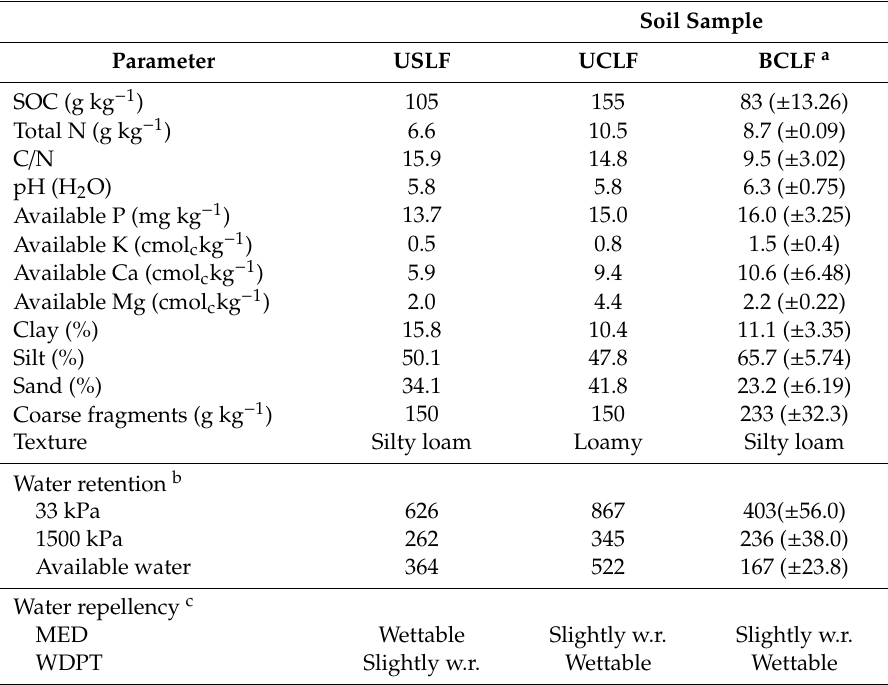
Table 1. Physicochemical characteristics of soils from Garajonay National Park in unburned and burned areas of the laurel